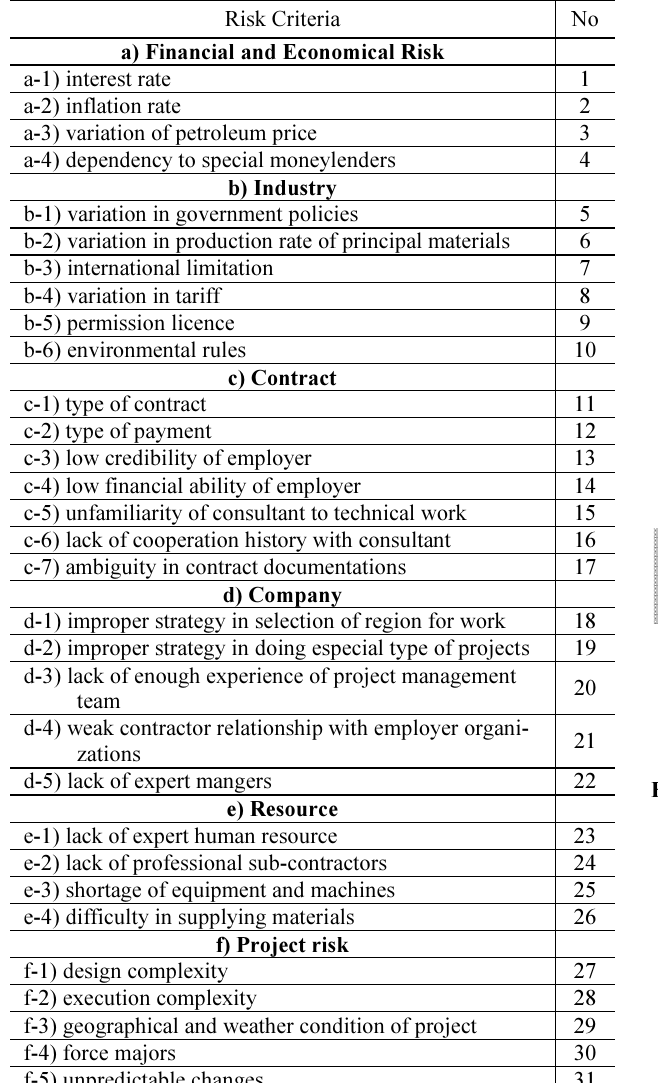
Fig. 3. The final fuzzy number of RELC